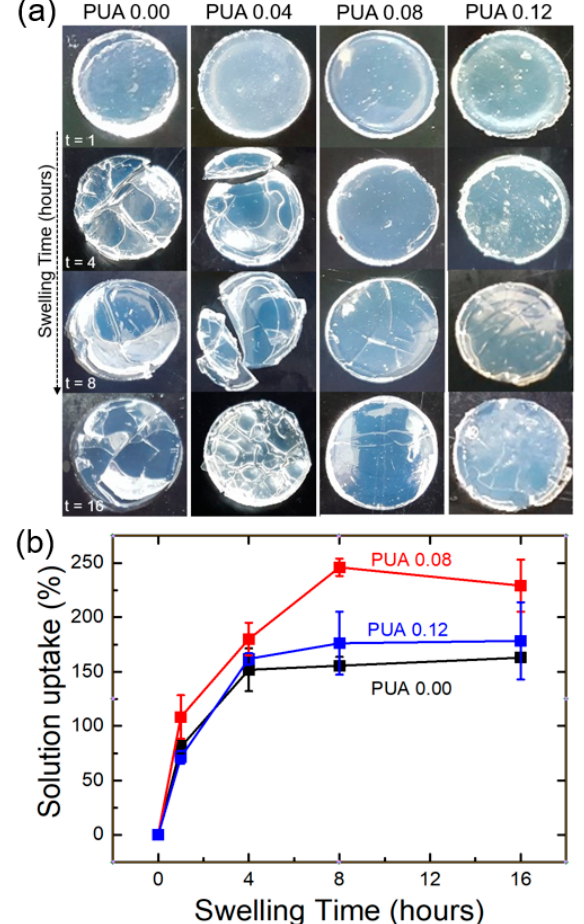
Figure 4. ( a ) Digital images of PUA membranes after swelling for 1 to 16 h (t = 1, 4, 8, 16) in 1 M LiPF 6 ethyl carbonate (EC) / dimethyl carbonate (DMC) and ( b ) solution uptake of the PUA samples as a function of the swelling time.